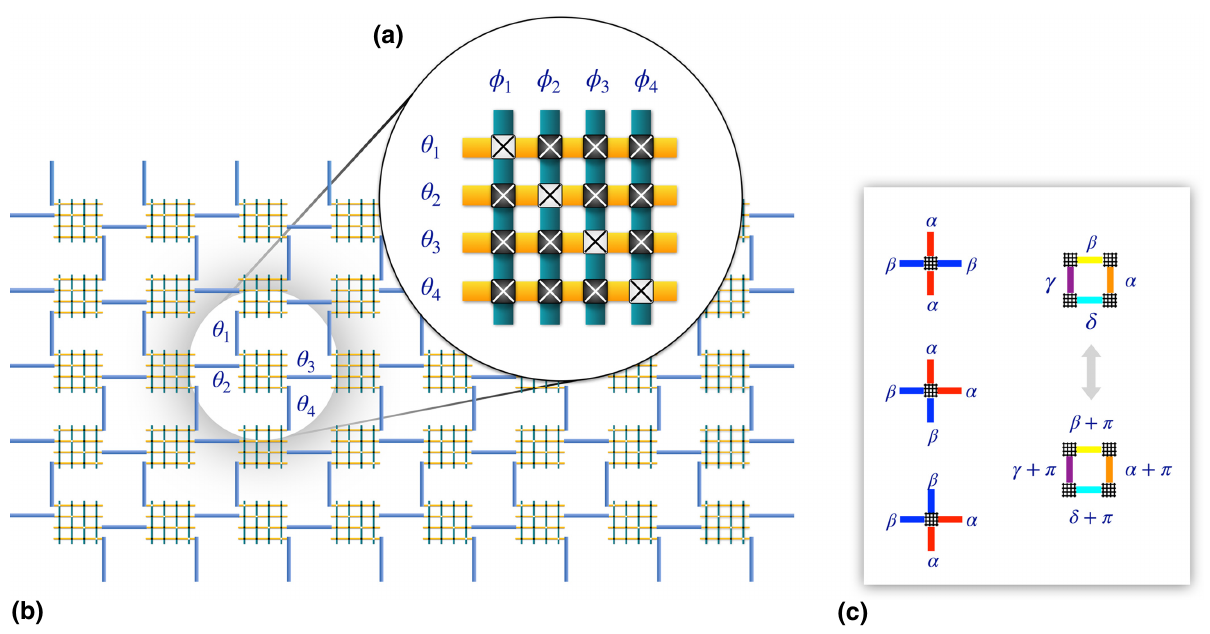
FIG. 1. (a) An array of intersecting superconducting wires which form a single “waffle” site in the lattice. Vertical (green) wires are “matter” degrees of freedom with phase φ n and charge q n . Horizontal (yellow) wires are “gauge” degrees of freedom with phase θ i and charge Q i . Wires are coupled by Josephson junctions depicted as black or white crosses depending on the sign of the coupling. This array mirrors the interaction matrix W and implements combinatorial gauge symmetry. (b) The full lattice with links (blue) connecting the gauge degrees of freedom. One site is highlighted to illustrate how sites are connected; links that it shares with neighboring sites are labeled by their gauge phases θ i . The matter wires with phases φ n are connected only to gauge wires. (c) This geometry leads to exact Z 2 topological order, as illustrated by the allowed configurations of the gauge phases θ emanating from each waffle site. We show the limit in which the capacitances are large (i.e., classical limit), where the gauge phases are good quantum numbers. Gauge phases must be equal pairwise α (red) and β (blue) at each site, where both phases are defined modulo π . In the context of lattice models, such vertices are related to loop models. Additionally, plaquettes may be flipped back and forth by shifting all gauge phases around the plaquette (α , β , γ , δ) by π